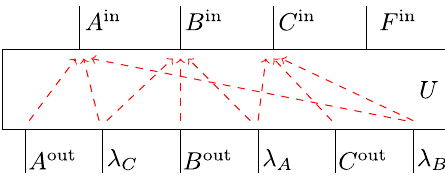
Fig. 8 The unitary map U from Eq. (13) that de fi nes the BW unitary extension of the AF process. Also depicted is its causal structure, where for better visibility, rather than direct cause relations, the no-in fl uence conditions are shown as red dashed arrows.